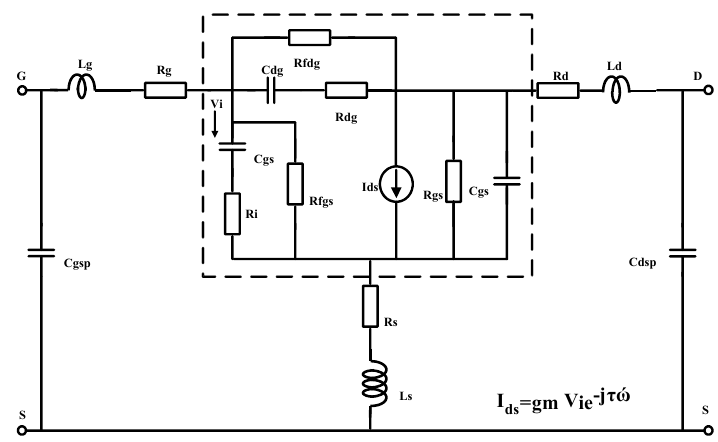
Figure 6. Small signal model of GaN HEMT (adapted from [31]).